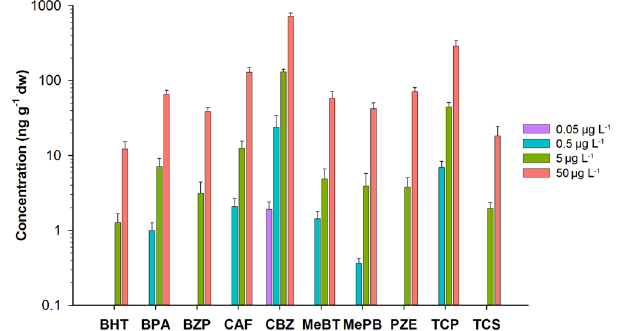
Figure 1. Mean concentration and standard deviation (N = 4) of the studied CECs in leaves (ng g − 1 dw) for the four different irrigation concentrations (0.05, 0.5, 5 and 50 µ g L − 1 ) in log